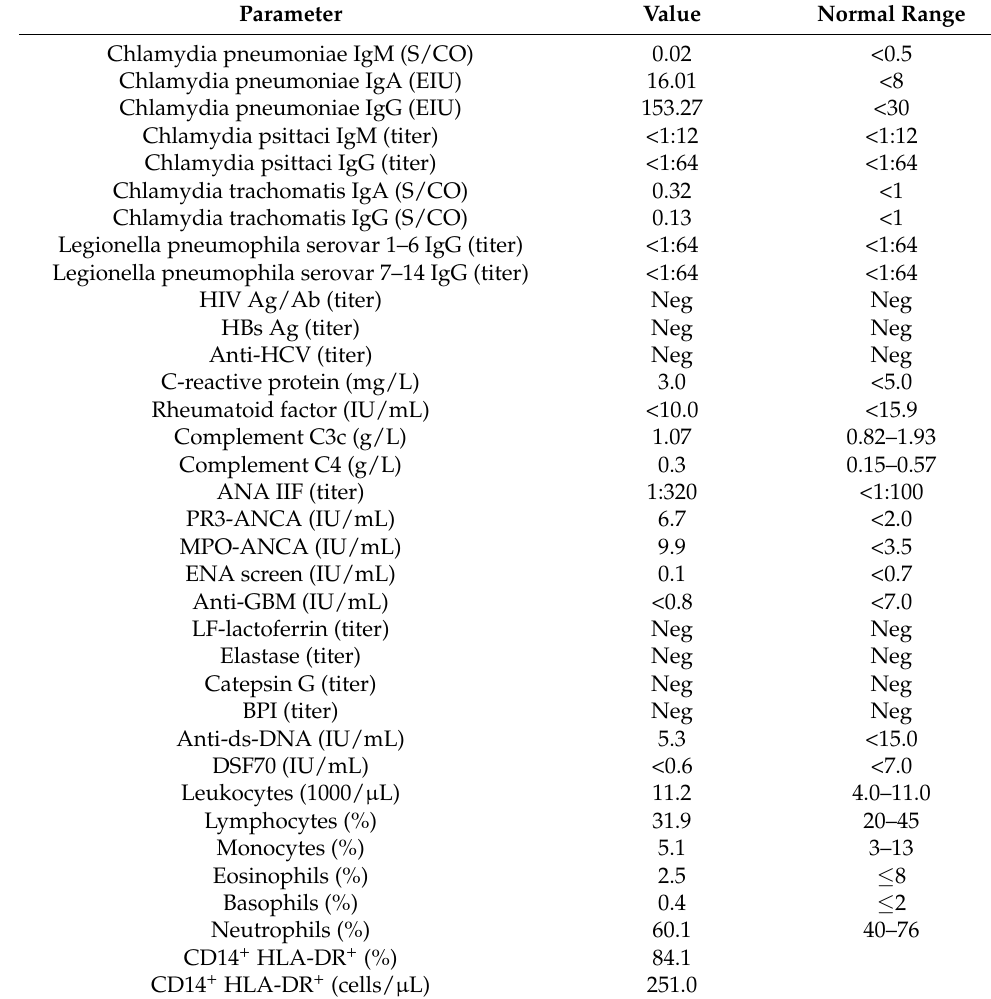
Abbreviations: ANA = antinuclear antibody; ANCA = anti-neutrophil cytoplasmic antibody; anti-GBM = anti- glomerular basement membrane; BPI = bactericidal permeability-increasing protein; CD14 + = cluster of differenti- ation 14 positive; ds-DNA = double-stranded-DNA; DSF70 = dense fine-speckled 70; ENA = extractable nuclear antigen; HBsAg = hepatitis B surface antigen; HCV = hepatitis C virus; HIV = human immunodeficiency virus; HLA-DR = human leukocyte antigen DR isotype; IIF = indirect immunofluorescence; MPO = myeloperoxidase; Neg = negative; PR3 = proteinase